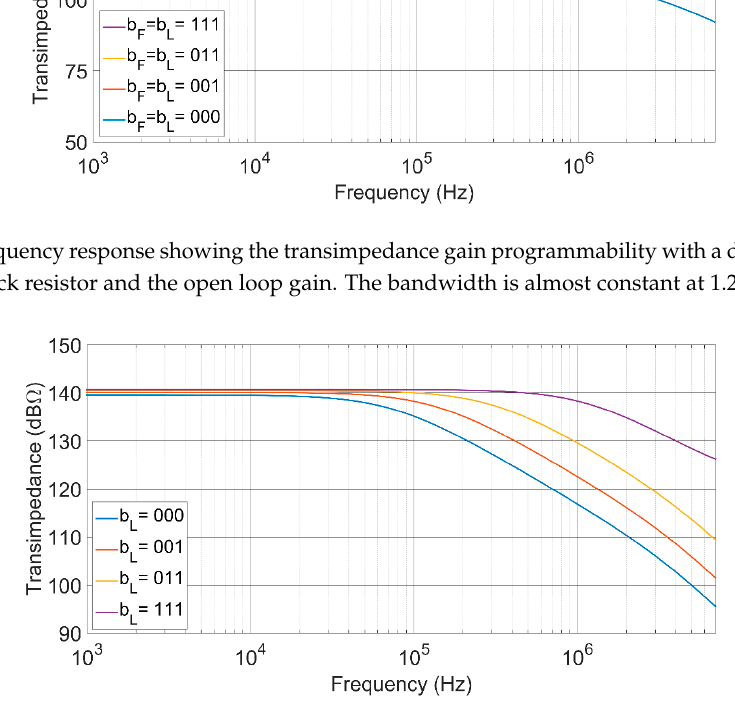
Figure 8. Frequency response with a single control of the open loop gain. The transimpedance gain is almost constant, at 140 dB Ω with feedback control word, b F = 111.